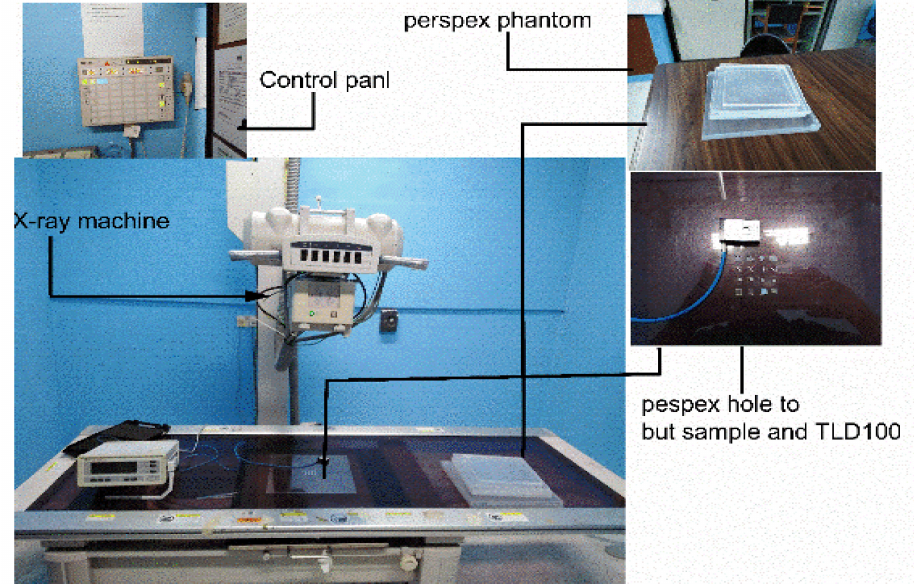
Figure 1. The schematic diagram of the experimental set-up for X-ray irradiation dose using Toshiba KXO-50S